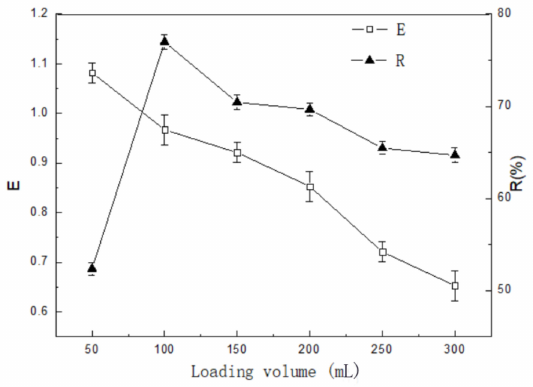
Figure 4. Effects of loading volume on enrichment ratio and recovery.